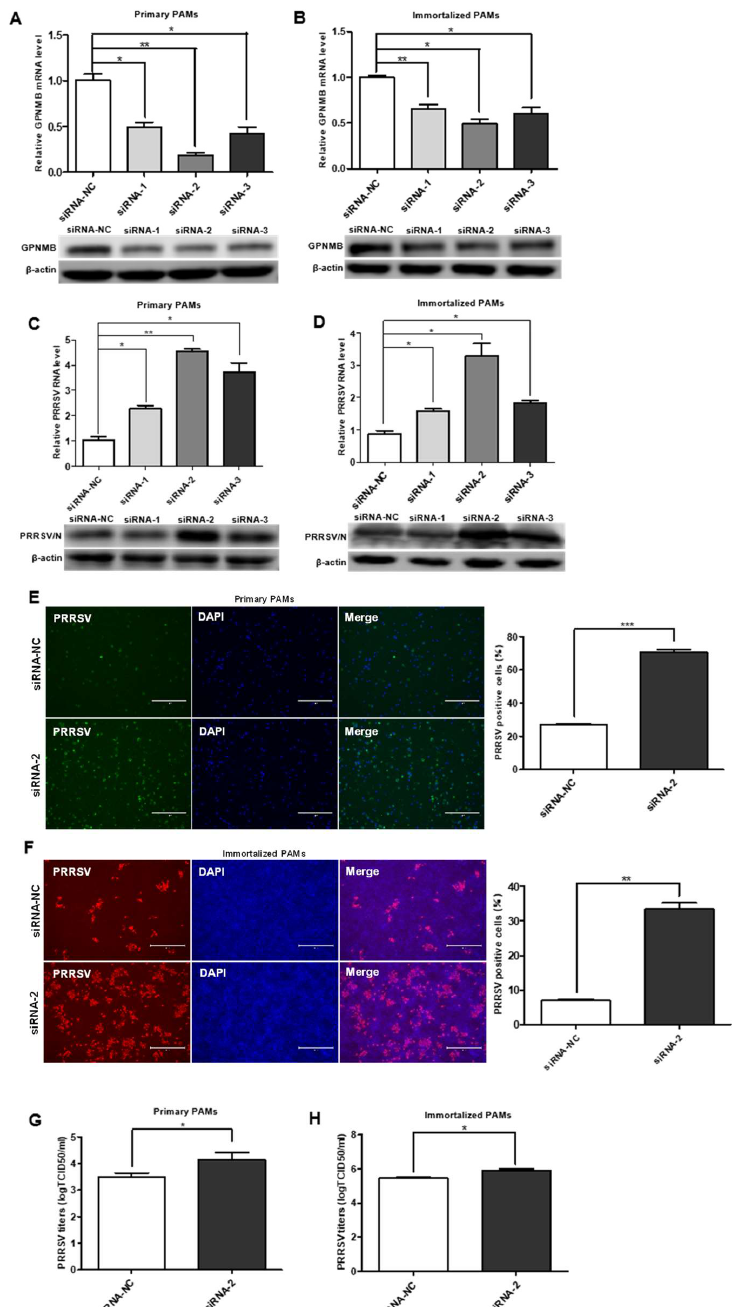
Figure 2. Knockdown of the endogenous GPNMB expression increases PRRSV infection. ( A – B ) GPNMB siRNA reduced endogenous GPNMB expression. Primary PAMs ( A ) and immortalized PAMs ( B ) were transfected with siRNA-GPNMB or siRNA-NC for 24 h, and the knockdown efficiency of GPNMB was determined by quantitative qPCR and Western blot. ( C – H ) Knockdown endogenous GPNMB expression facilitates PRRSV infection. Cells were transfected with siRNA-GPNMB or siRNA-NC for 24 h, and cells were then exposed to PRRSV for 24 h. The levels of viral RNA and protein in Primary PAMs ( C ) and immortalized PAMs ( D ) were determined by quantitative qPCR and Western blot; Primary PAMs ( E ) and immortalized PAMs ( F ) cell monolayers were fixed and examined for virus infection by IFA; and virus titers in Primary PAMs ( G ) and immortalized PAMs (H) were evaluated with TCID50. Results are representative of three independent experiments (means ± SD). * p < 0.05; ** p < 0.01; *** p < 0.001. The p -value was calculated using Student’s t